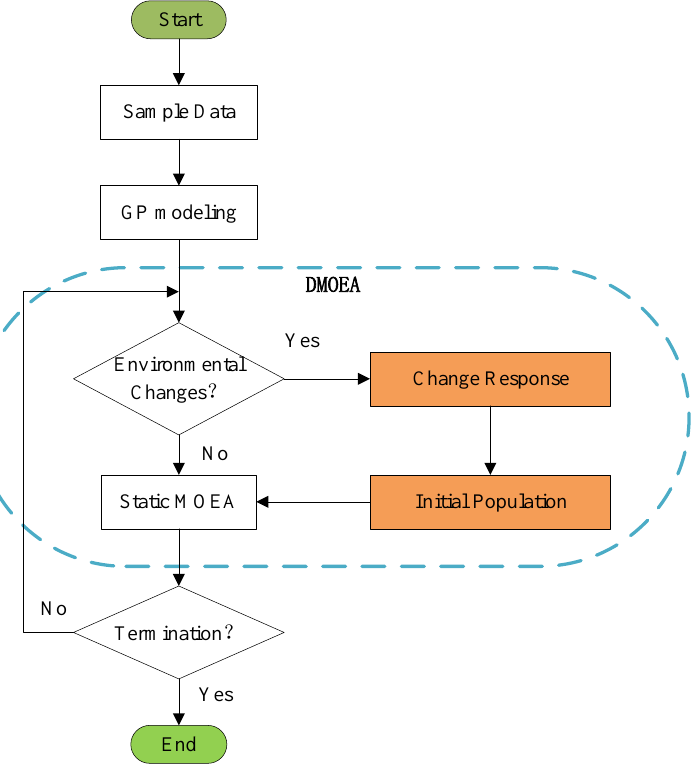
Figure 3. The diagram of dynamic optimization for carbonization